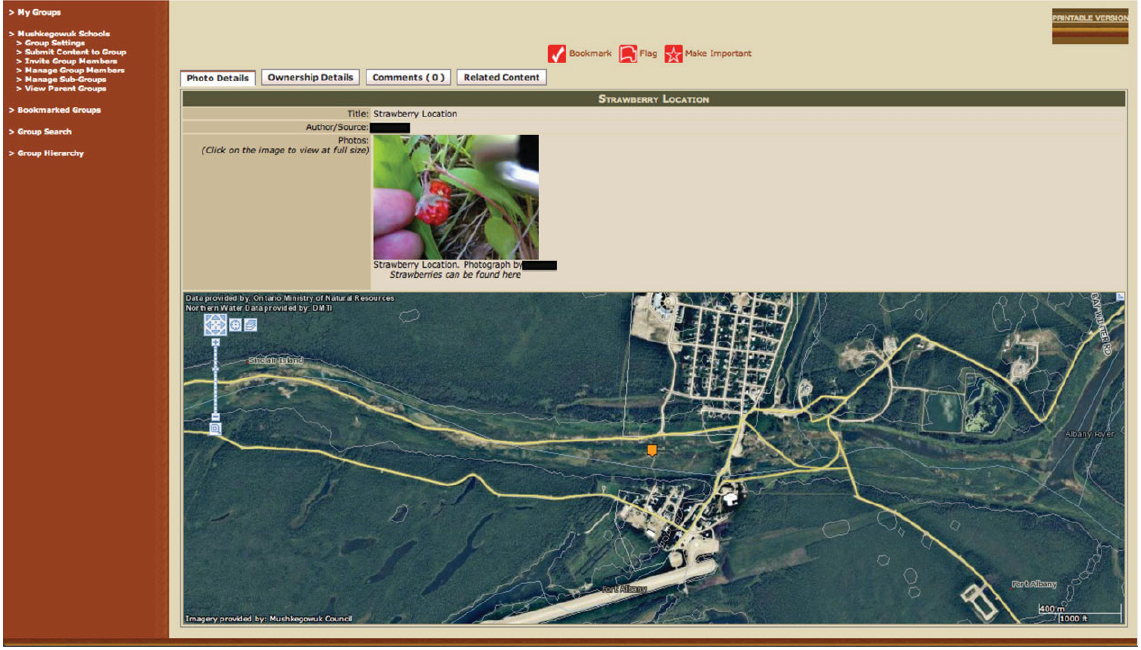
(Colour online) Screenshot of the collaborative-geomatics informatics tool, displaying a photograph taken by a student of where strawberries can be found. longitude and latitude in class; the use of the GPS